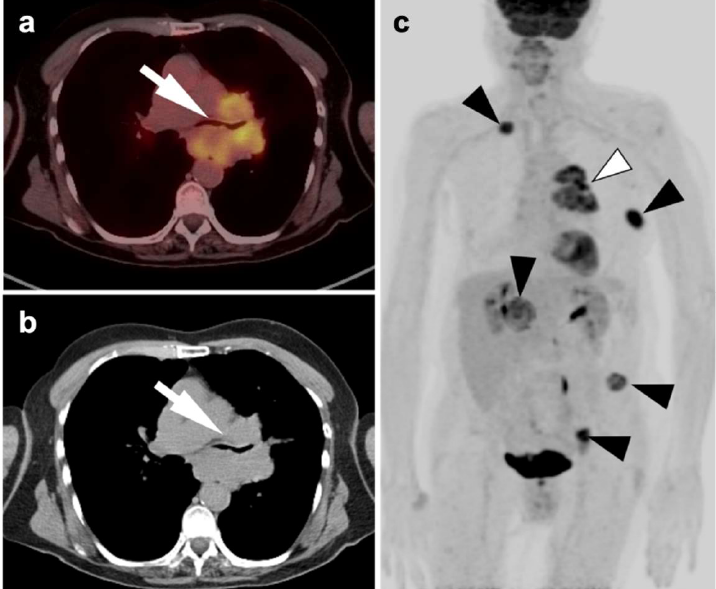
Figure 10. Patient with long history of cigarette smoking and history of weight loss, cough, and shortness of breath. ( a ) Fused axial FDG PET-CT axial and axial CT ( b ) images demonstrate a hypermetabolic mass involving the left hilar and perihilar region with narrowing of the left mainstem bronchus ( white arrows ); ( c ) whole-body MIP image demonstrates the left hilar hypermetabolic mass ( white arrowhead ), and multiple metastatic lesions ( black arrowheads ) in the right lower neck, left lateral chest wall (rib), right adrenal, left iliac wing, and a left pelvic sidewall node consistent with stage IV disease. Histopathology confirmed NSCLC.